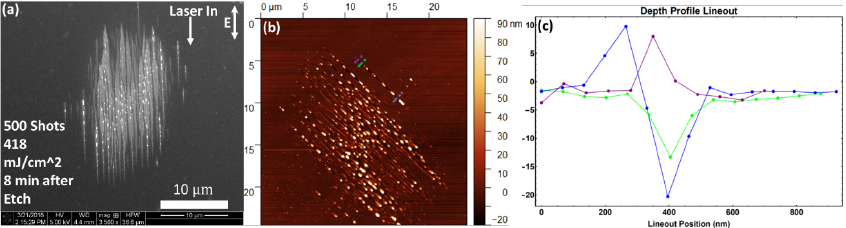
Figure 5. SEM and AFM images of multi-shot LID on silicon (111) with 500 shots, with oxide layer etched 8 min prior to exposure at a low fluence. ( a ) SEM image, indicates the fluence, laser input direction, and polarization projected onto the sample surface; ( b ) AFM depth profile, blue, green, and red dotted lines indicate lineouts in ( c ).